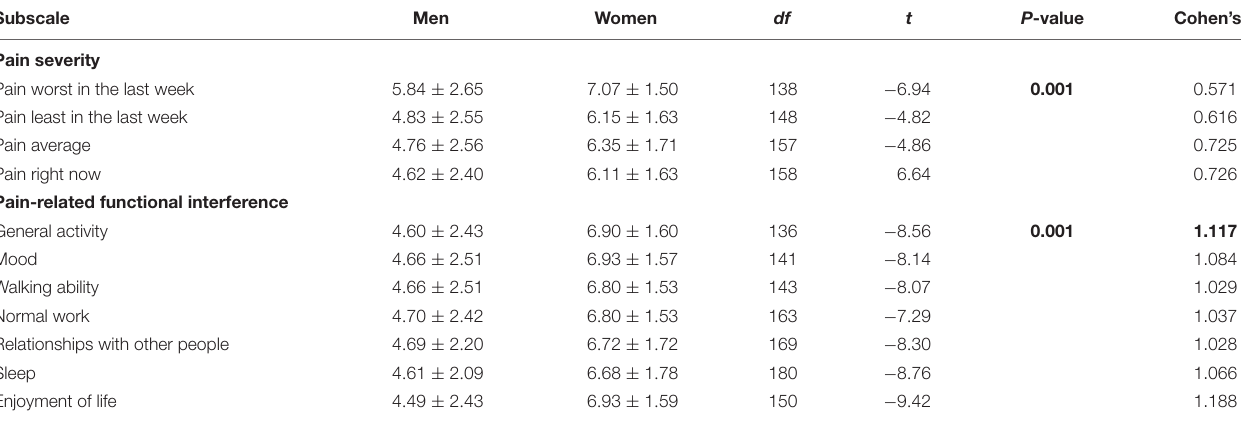
TABLE 3 | Gender differences between pain severity and pain-related function of the participants.